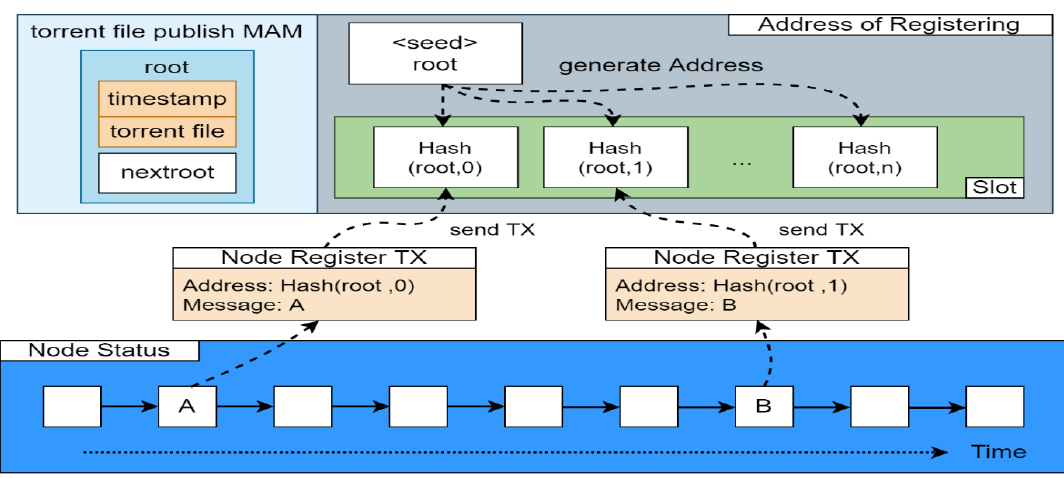
Figure 8. Time difference registration method. Figure 8. Time di ff erence registration